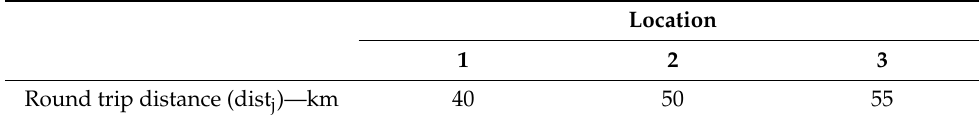
Table 7. Location related